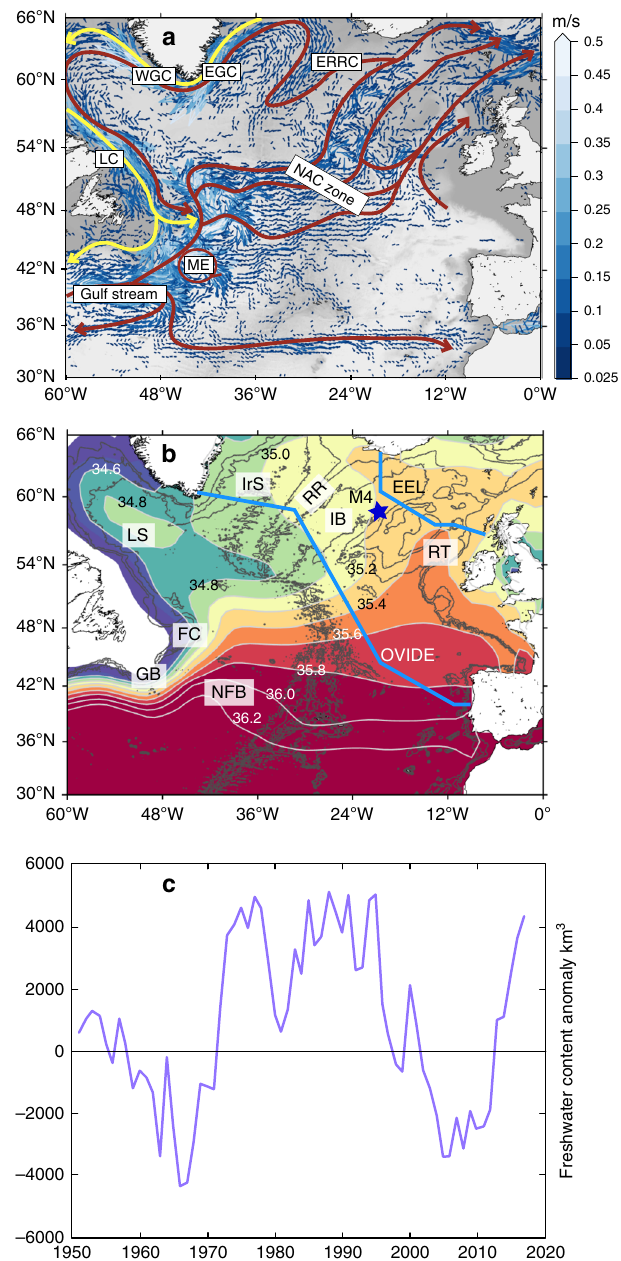
Fig. 1 North Atlantic circulation, surface salinity and changing freshwater content. a mean circulation of the North Atlantic Ocean illustrated with mean surface current vectors overlain by schematic representation of major currents including the North Atlantic Current (NAC), East Reykjanes Ridge Current (ERRC) East Greenland Current (EGC), West Greenland Current (WGC), Labrador Current (LC) and Mann Eddy (ME); b mean surface salinity fi eld from the EN4 dataset (2004 – 2016) with major bathymetric features labelled, including Labrador Sea (LS), Irminger Sea (IrS), Reykjanes Ridge (RR), Iceland Basin (IB), Rockall Trough (RT), Flemish Cap (FC), Grand Banks (GB) and Newfoundland Basin (NFB), the Extended Ellett Line (EEL) and OVIDE sections (blue lines), and the M4 mooring (blue star); c annual time series of subpolar North Atlantic freshwater content of the upper 1000 m, derived from the EN4 dataset and integrated over the region 47 – 65°N, 0 – 60°W (see Methods). Figure 2, annual salinity anomalies in the 0 – 200 m layer. Data from the EN4 dataset, mean period (shown top left) is 2005 –